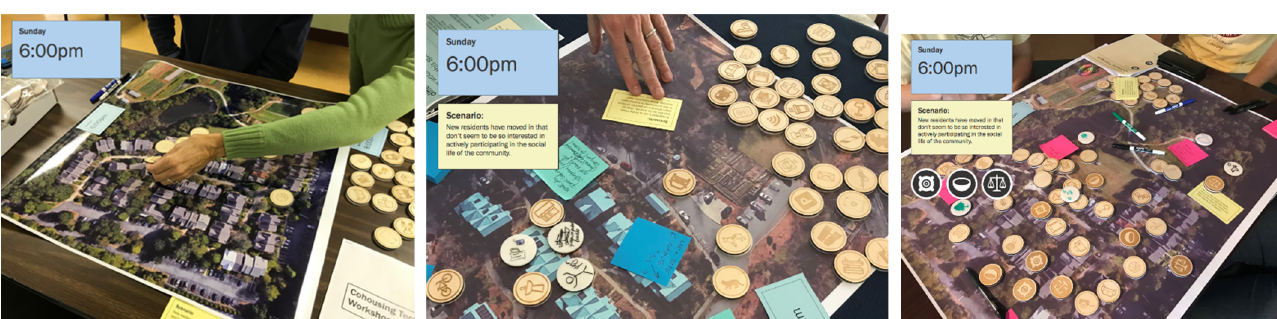
Figure 7. In the first phase of the device landscape game, left, residents have chosen Sunday at 6:00 p.m. In the second phase of the device landscape game, center, residents respond to a scenario and modify the device landscape to take that change into account. In the third and final stage of the device landscape game, right, cohousing residents imagine roles for the three prototypes as component parts of the device landscape for cohousing.